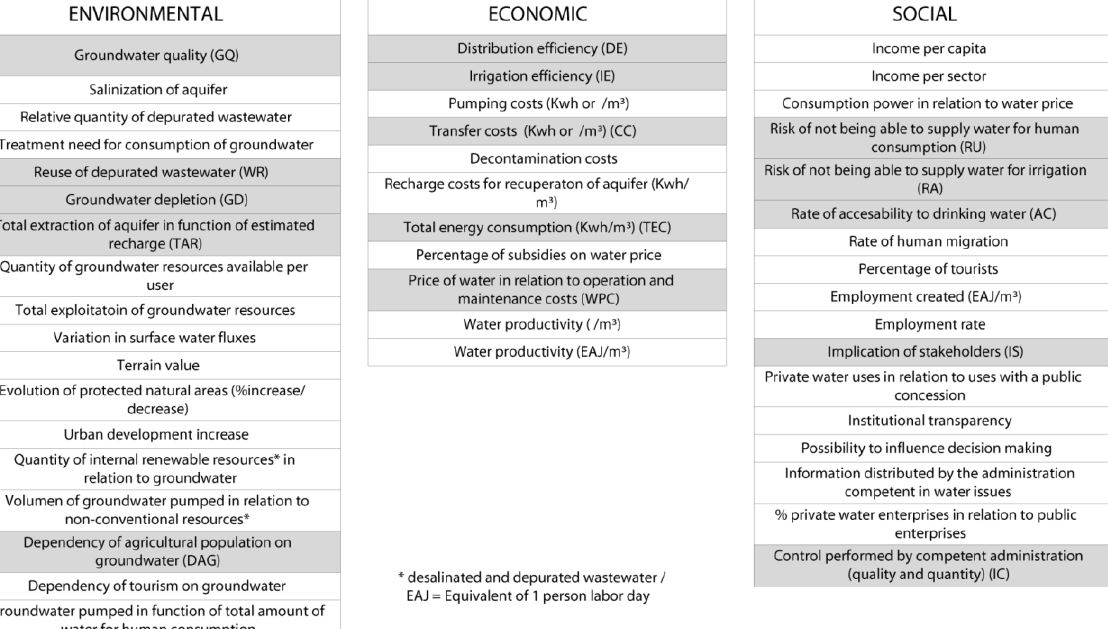
Figure A1.1: Architecture of the spatial decision support system (SDSS), with (1) a spatial database manager, (2) a scenario and alternatives generator and (3) a user interface embedded in a web 2.0 environment